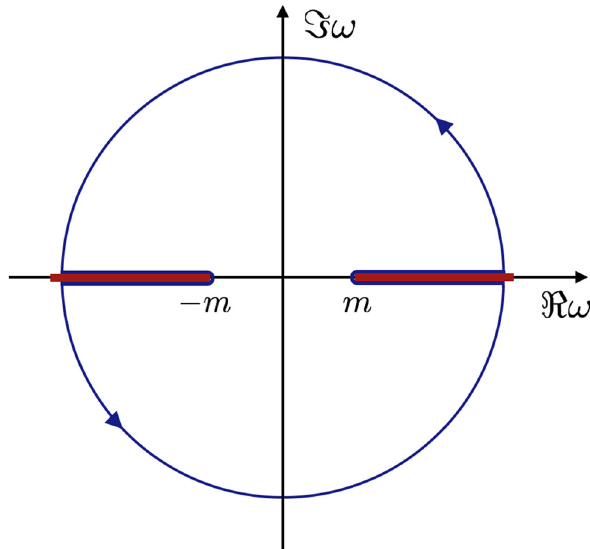
Fig. 2 Complex plane of the ω